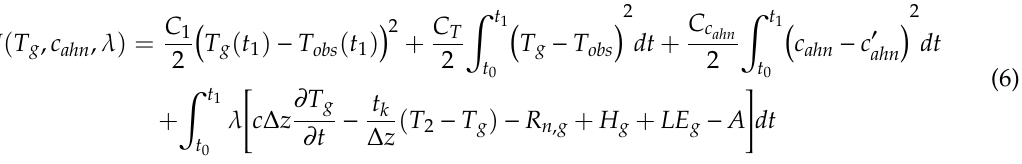
( b ) Figure 3. ( a ) Site average diurnal cycle of the sensible heat flux before and after assimilation; ( b ) comparison of the site average sensible heat flux differences with the LST differences from the control run and contrast run. Time series and diurnal cycles of the site average LST estimation from the control run and contrast run compared with the observation are shown in Figure 4. The biases, mean errors (MEs), root mean square errors (RMSEs) and correlation coefficients (Rs) are listed in Table 1. After assimilation, the simulated LSTs improved significantly. The bias decreased about 95%; the RMSE decreased about 74%; the R increased too. From Figure 4b, it was concluded that after assimilation, the simulated LSTs improved more in the daytime, especially from 10:00 to 19:00, because the sensible heat flux was relatively high in the daytime.